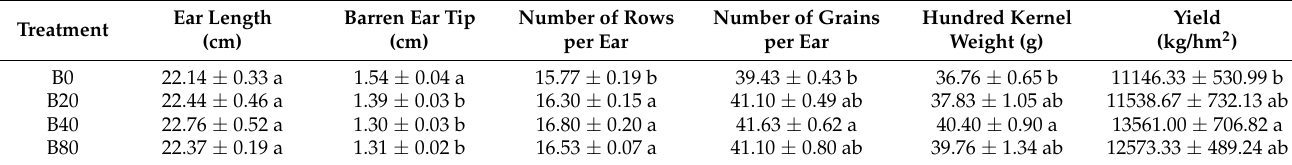
Table 5. Effects of biochar on yield traits of